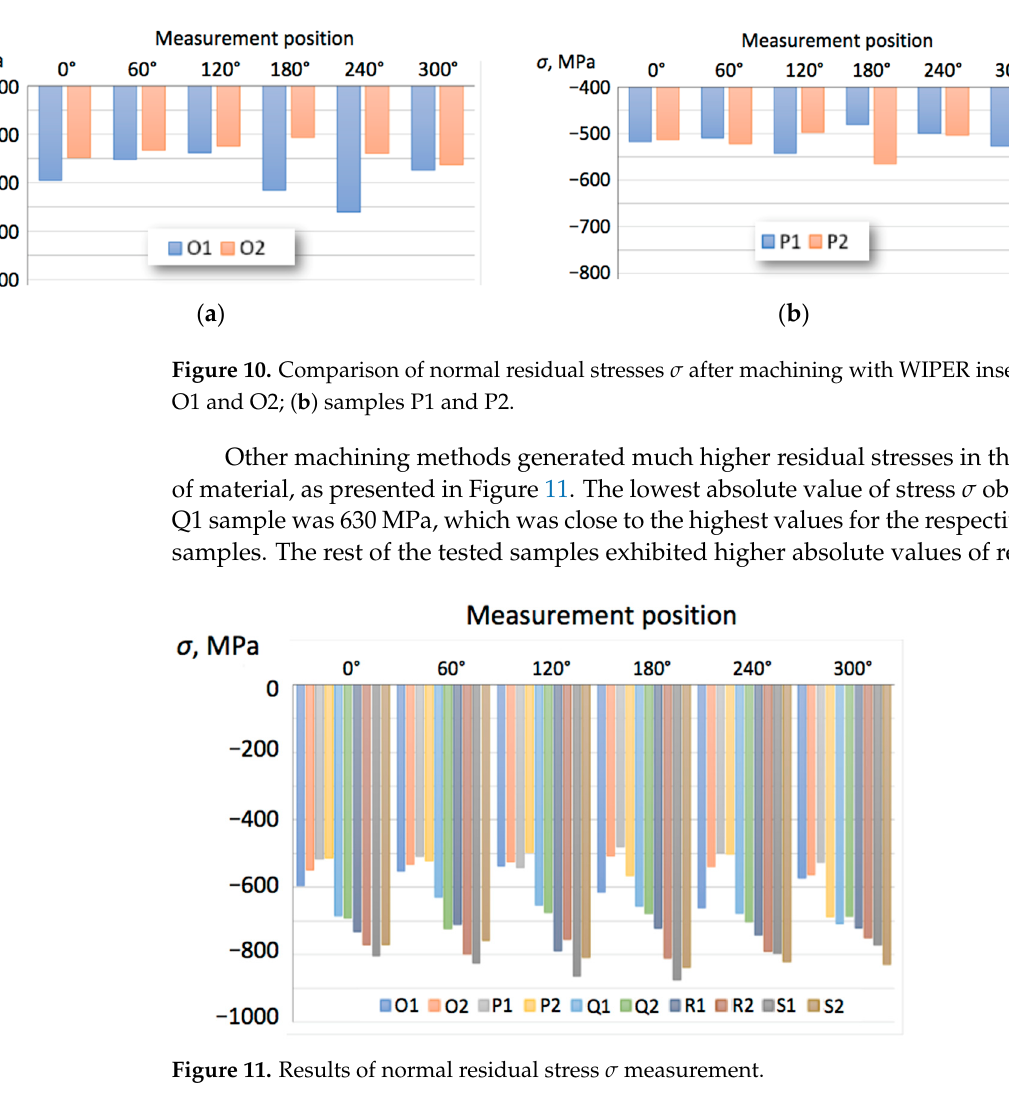
Figure 12. Results of shear stress τ measurement.